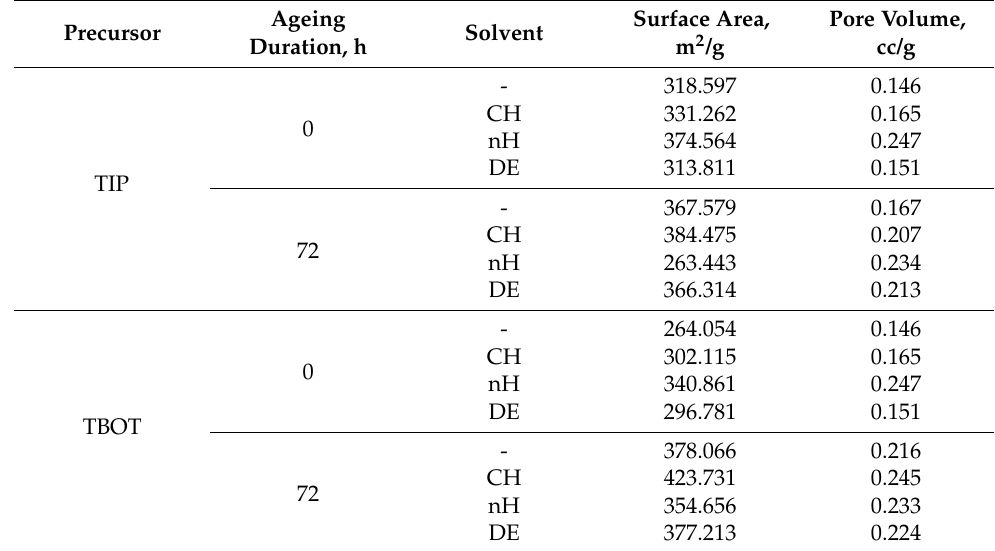
Table 2. Morphological parameters of TiO 2 aerogels vs. precursor nature, solvent type, and ageing duration.